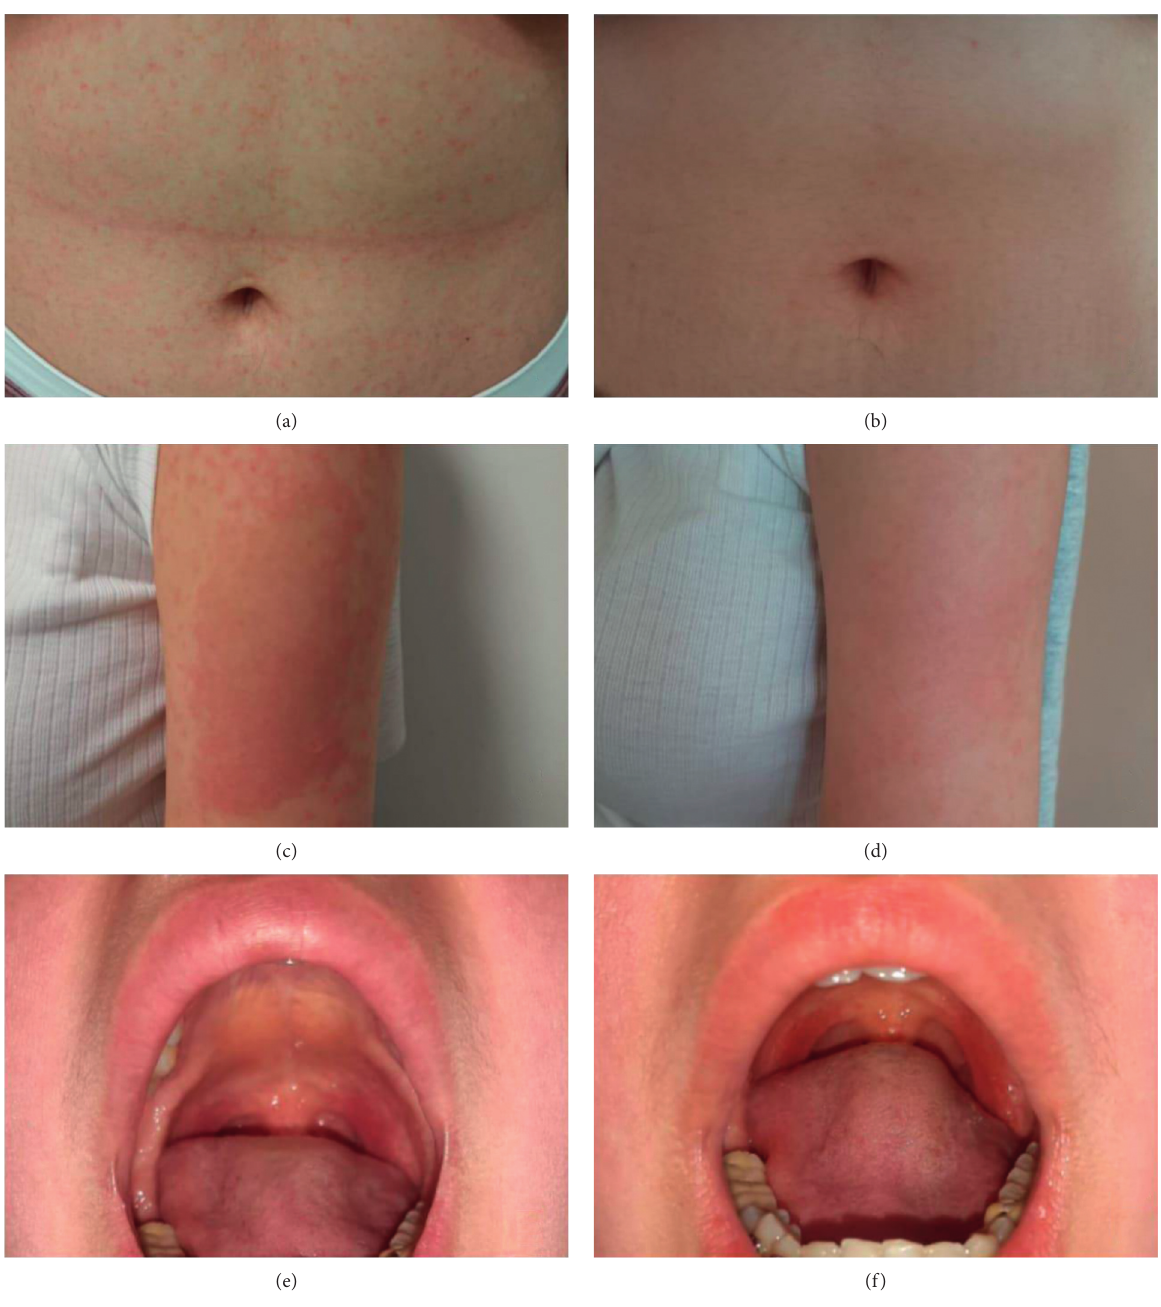
Figure 1: Clinical presentation. (a) The maculopapular exanthem at admission. (b) Regression of the maculopapular exanthem after a week. (c) Erythema of the injection site at admission. (d) Injection site after a week. (e) The enanthem at admission. (f) Persistence of enanthem after a